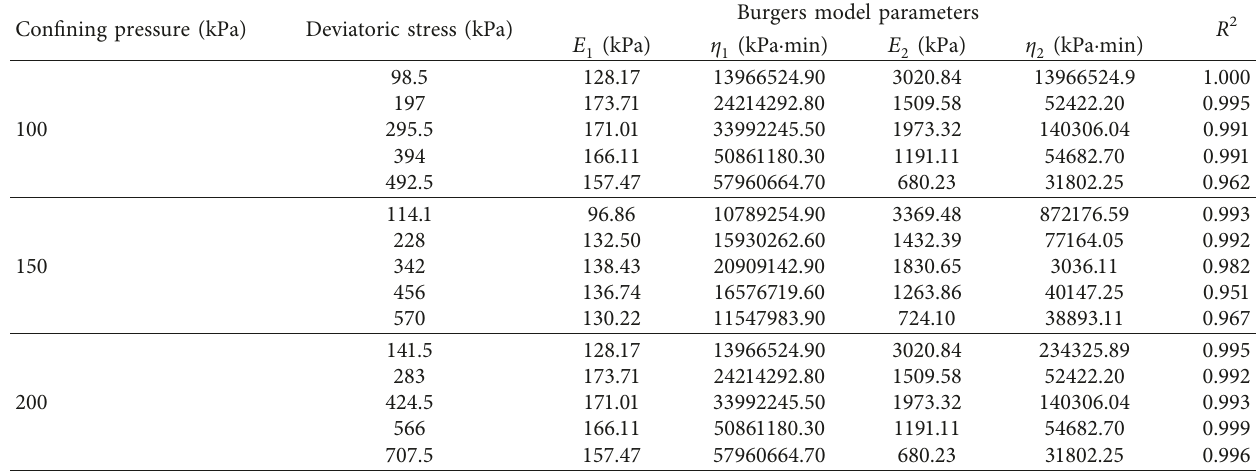
Table 3: Burgers model creep parameters of the BRM under different confining pressures.